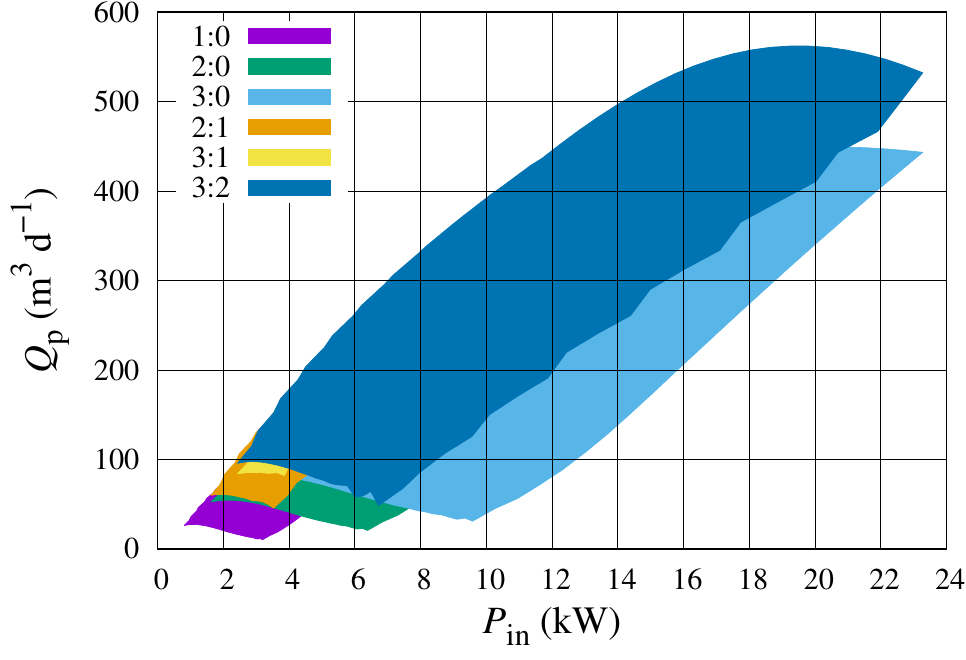
Figure 4. Permeate production for different BWRO configurations using sample 11 (Table 1) as C f